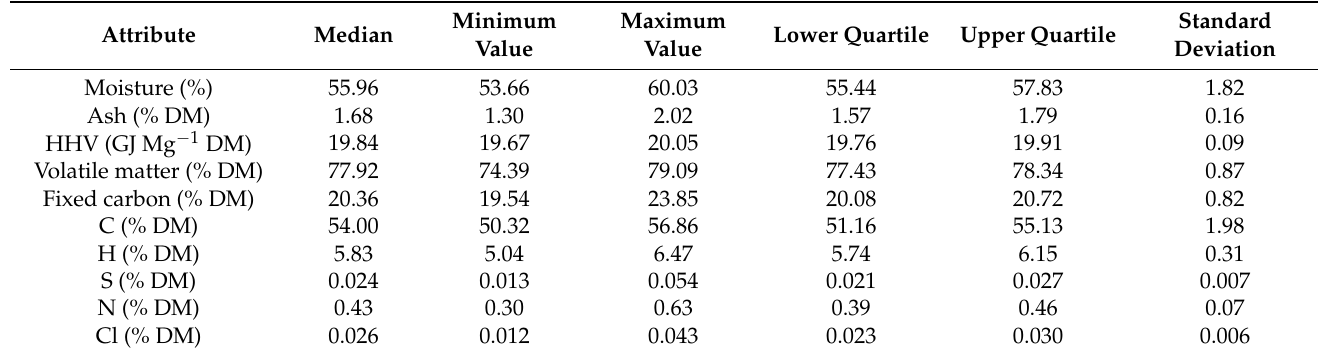
Table 7. Selected statistical analysis indicators for the poplar characteristics under